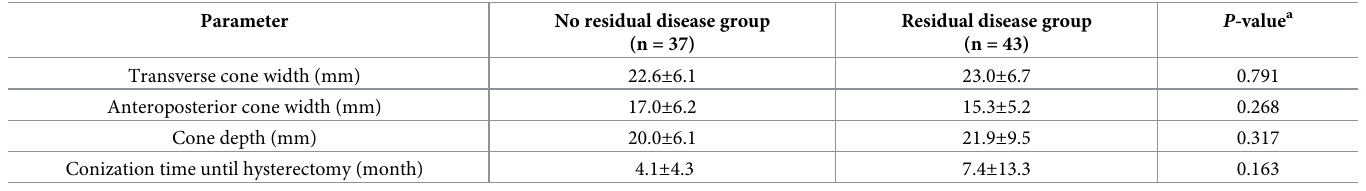
Table 2. Analysis of cone surgical characteristics as possible risk factors for the presence of residual disease in the hysterectomy specimens of women after coniza- tion for CIN 2/3 with endocervical cone margin involvement (mean ± SD).